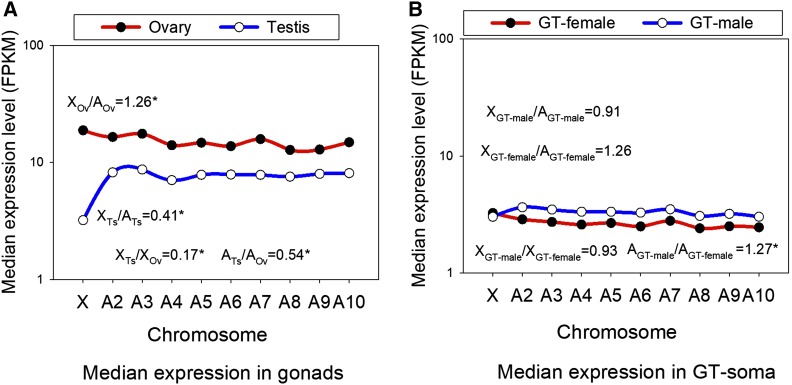
Median expression in the male and female tissues on each of the ten chromosomes in T. castaneum for genes with orthologs. A) Gonads; B) GT-soma. For panel A, the ratio of median expression on the X chromosome (X) and autosomes (A) for testis-biased genes and for ovary-biased genes are shown (XTs/ATs and XOv/AOv). Also shown are XTs/XOv and ATs/AOv. Panel B contains the equivalent results for the GT-soma. *Indicates a statistically significant difference between the two groups contained in each ratio using MWU-tests.